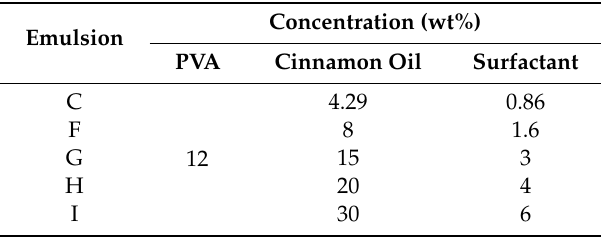
Table 2. Cinnamon oil / PVA emulsion concentrations for imparting acaricidal e ff ects against house dust